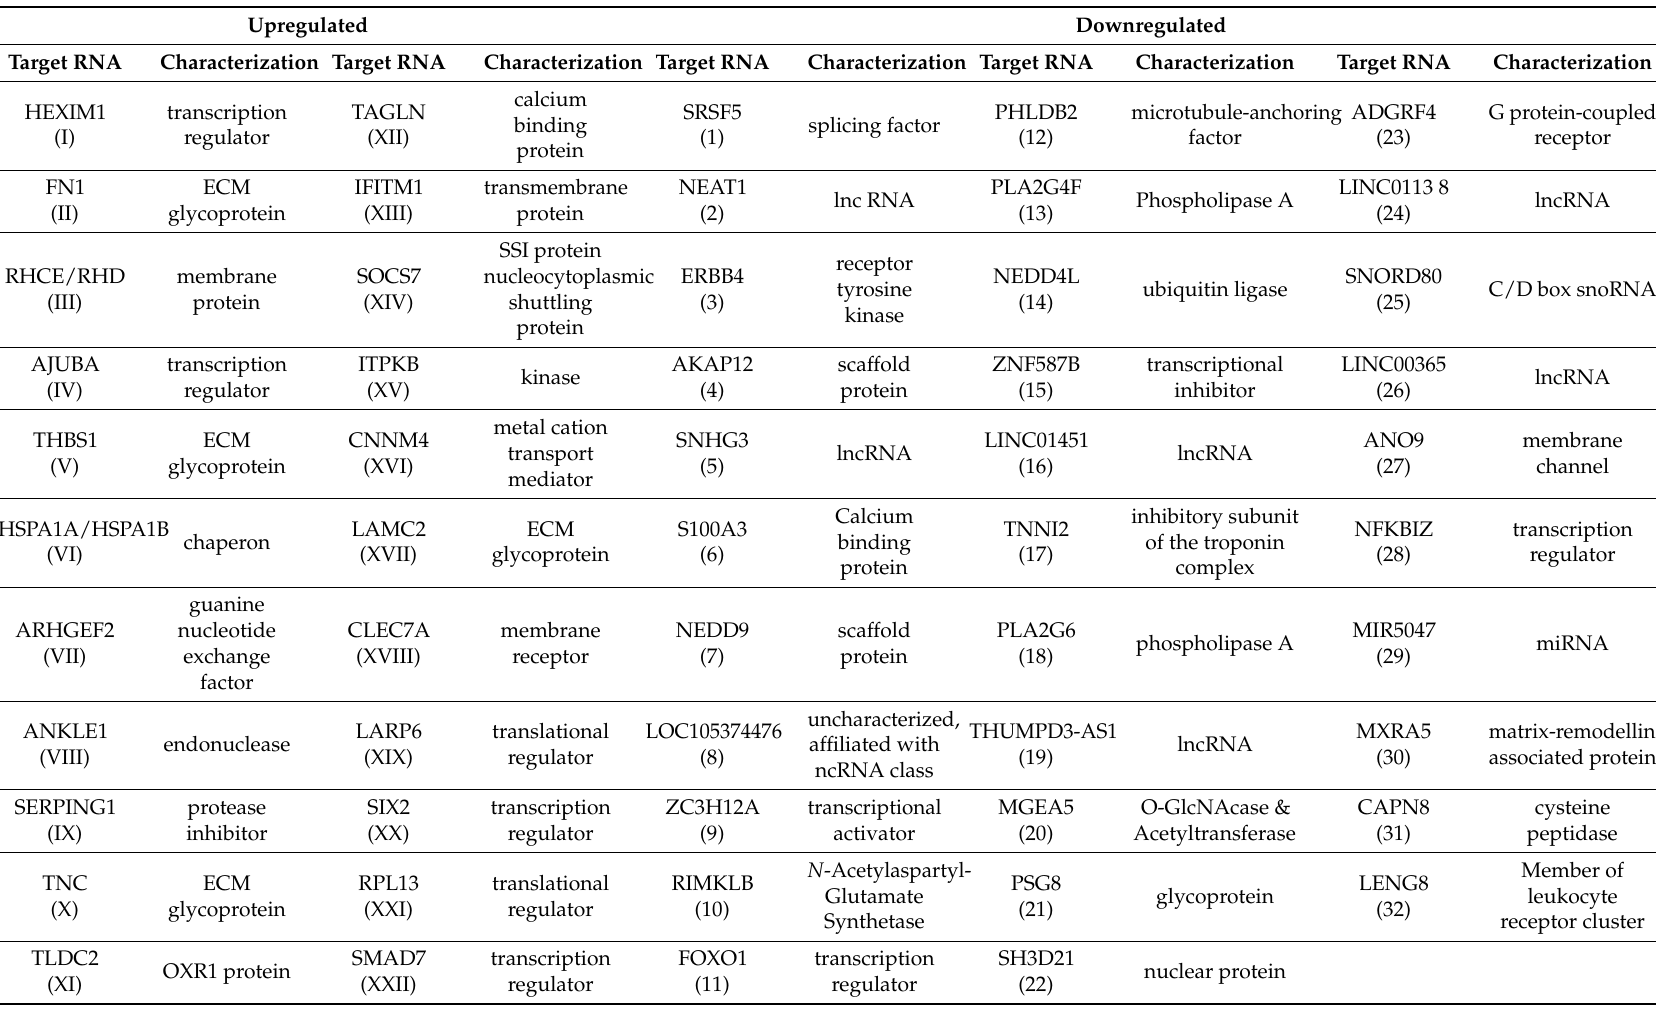
Table 1. Overview of the 54 HBoV-specific regulated genes. The table shows that during HBoV infection, 22 transcripts are upregulated (Roman numerals), whereas 32 transcripts are downregulated (Arabic